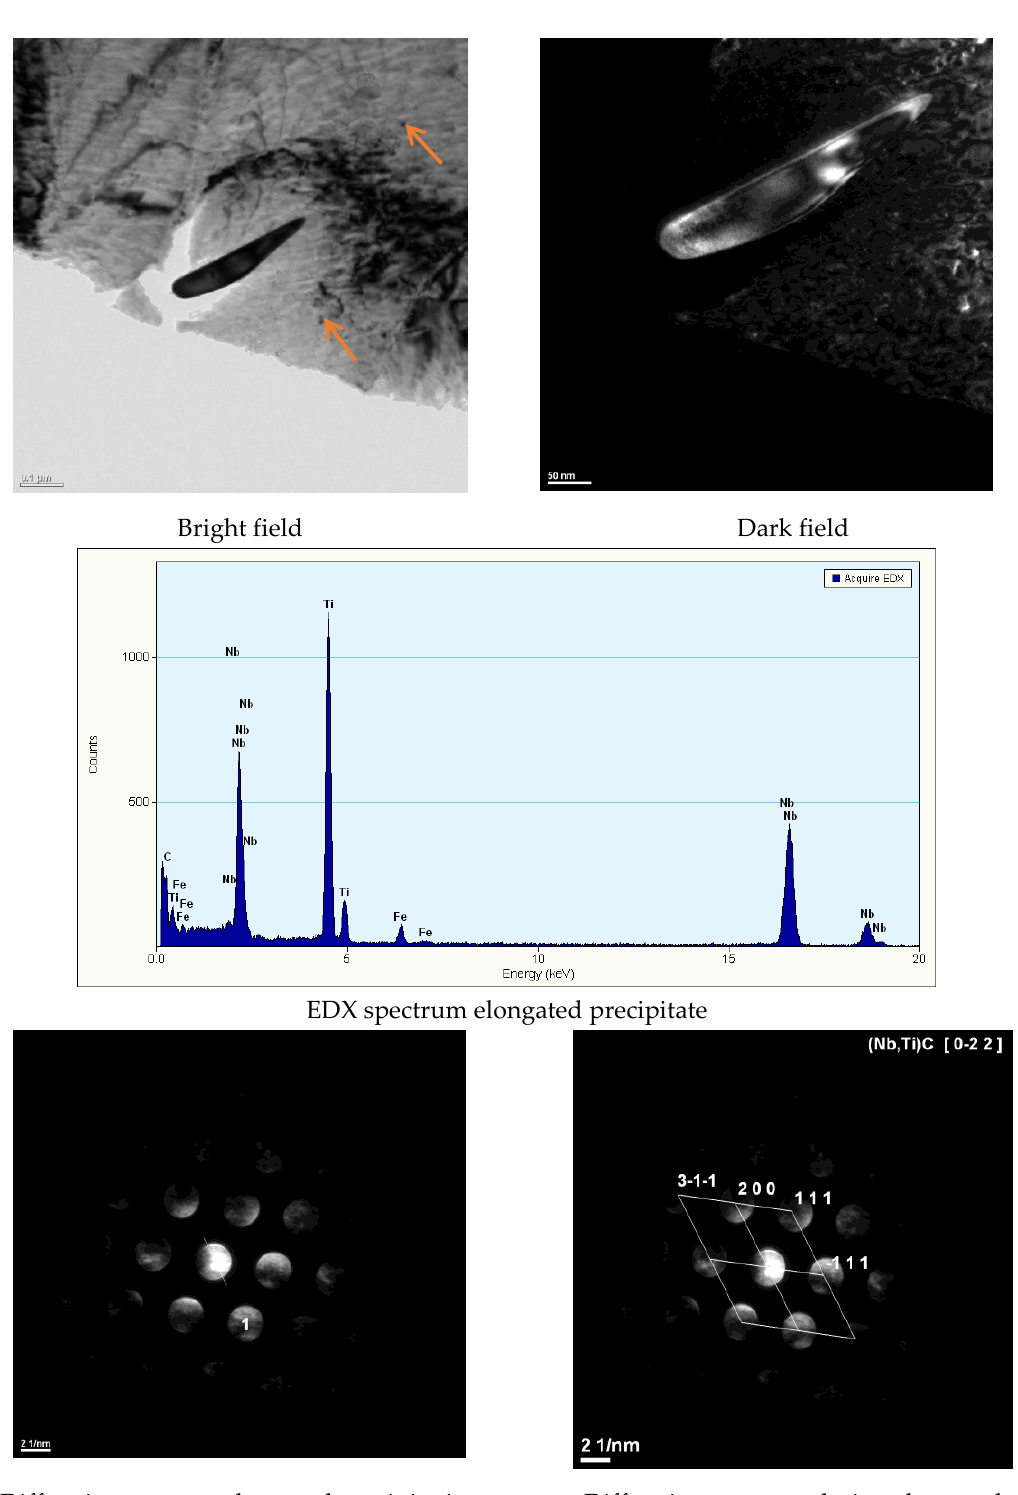
Figure 6. Carbonitride precipitate elongated precipitation (Nb,Ti)C with single fine-dispersive precipitates responsible for steel hardening (marked with an arrow).